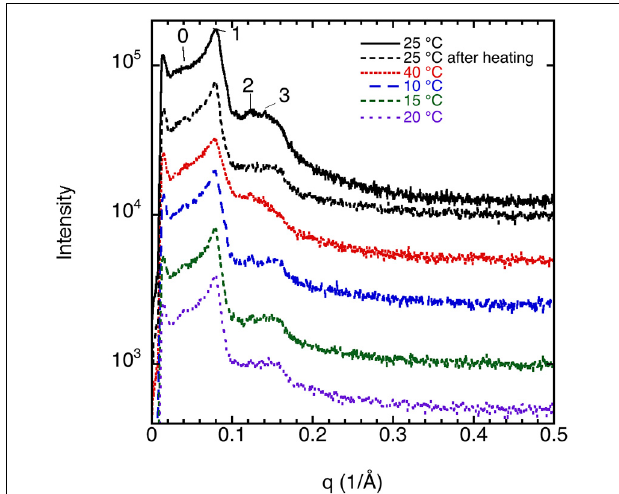
FIGURE 10 | SAXD data for 70 wt% brain lipid extract in 0.9 wt% NaCl and 1 mM CaCl 2 as function of temperature. The interlayer spacing of the different peaks (0, 1, 2, and 3), together with their relative intensity, is shown in Table 3 . Here peak 1 is the only well resolved peak with the highest intensity, while the 0 peak appears as a shoulder. Note the different diffractograms are displaced to facilitate comparison.